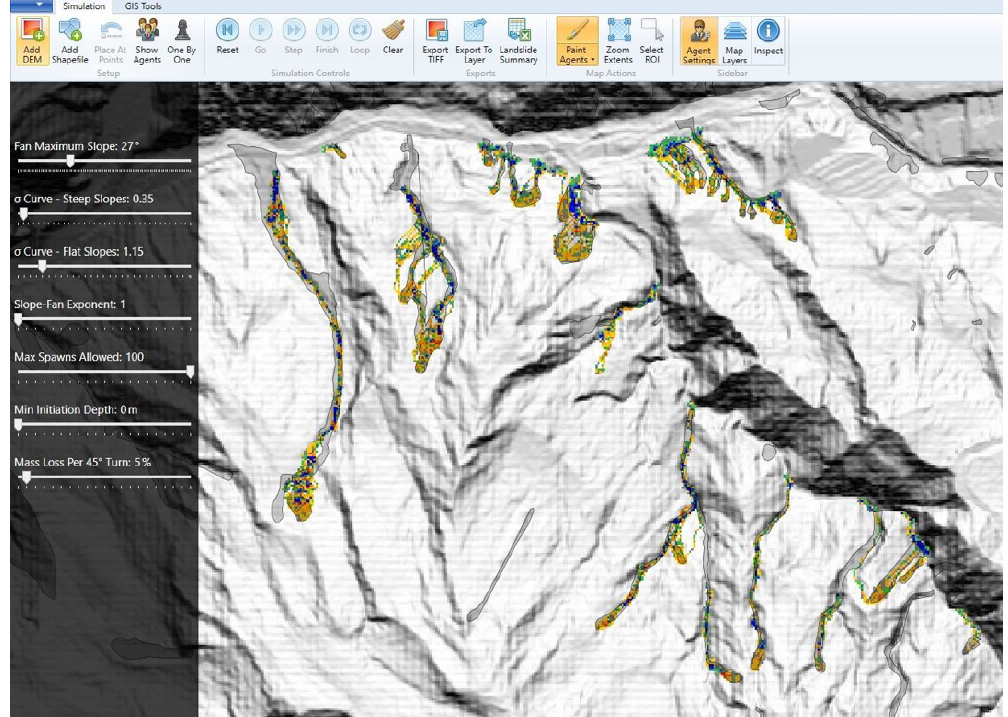
Figure 11. A single run of the landslides whose initiation zones were painted in Fig. 10 above. Colors relate to scour (yellow to red where red is deeper) and deposition (green to blue where blue is deeper). Table 4. Accumulated landslide-generated sediment (in m 3 ) by return period of landslide-generating storms. Storm return period